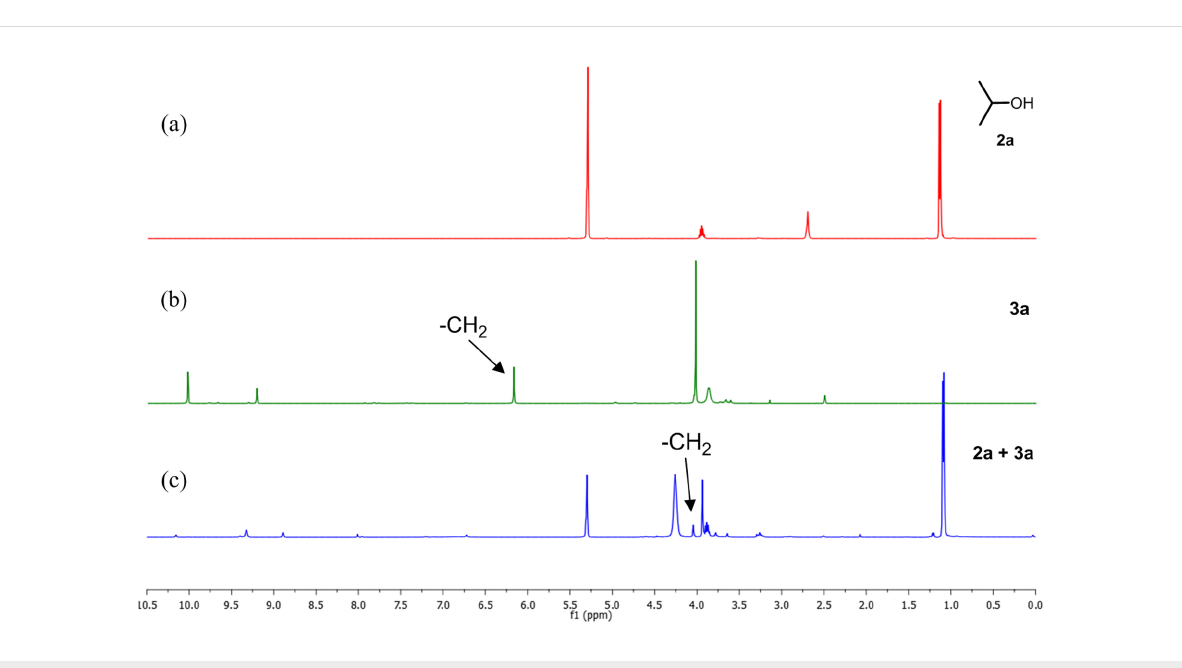
Figure 2: 1 H NMR (a) glycosyl acceptor 2a , (b) pyridinium salt 3a (in DMSO- d 6 ) and (c) a mixture of 2a and 3a in 1:1 ratio in CD 2 Cl 2 at room